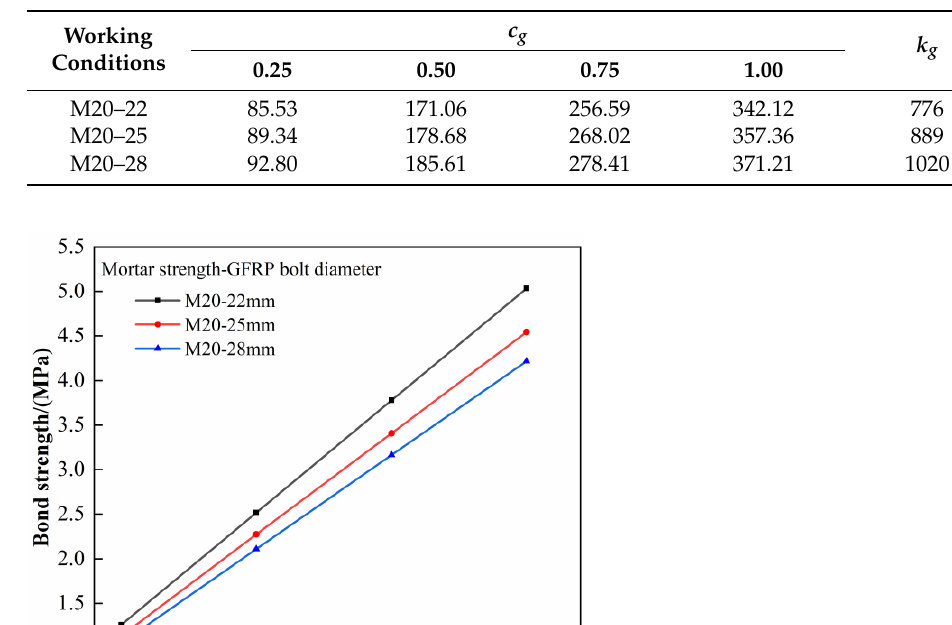
Table 6. Grout parameters for mortar specimen M20.